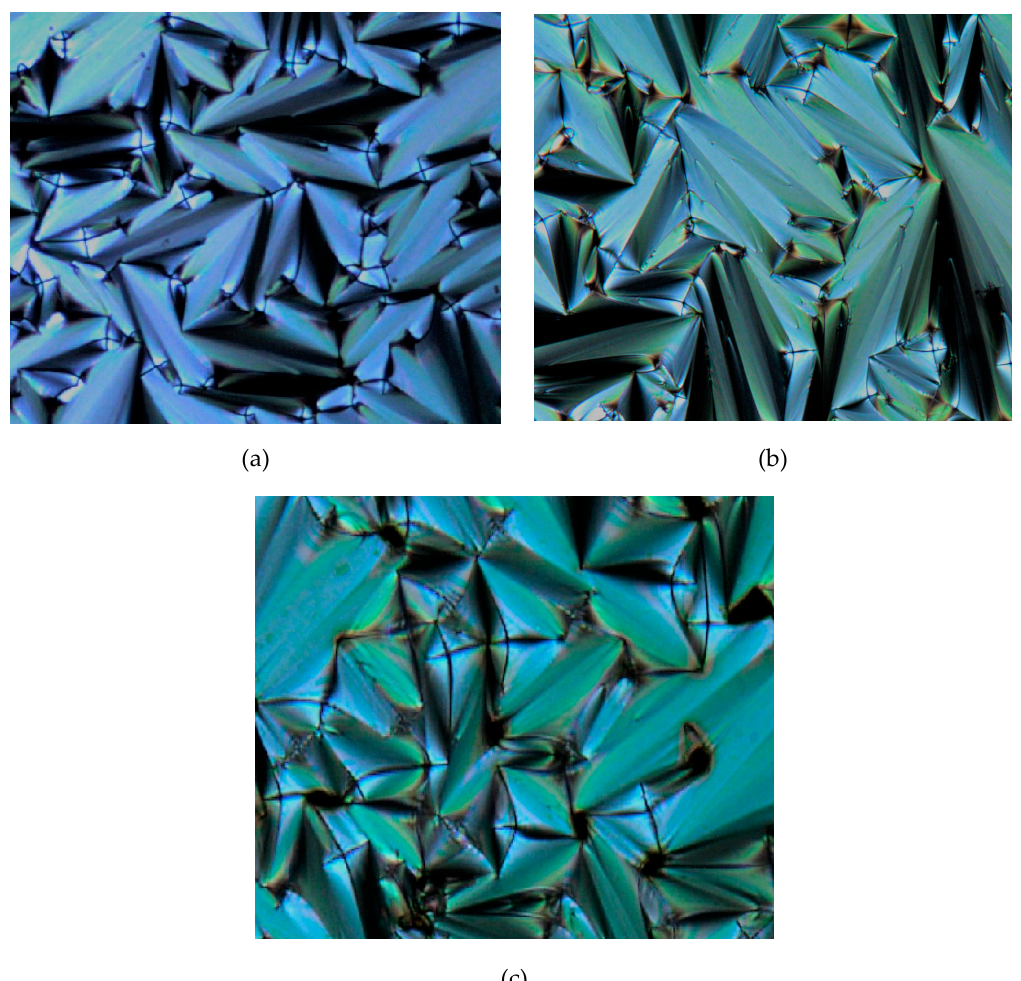
Figure 9. The optical photomicrographs of compounds 4b – d in the heating cycle showing the focal conic fans of SmA phase: ( a ) 4b at 188.15 °C, ( b ) 4c at 179.33 °C, and ( c ) 4d at 180.48 °C (Magnification of 20 × 0.50).